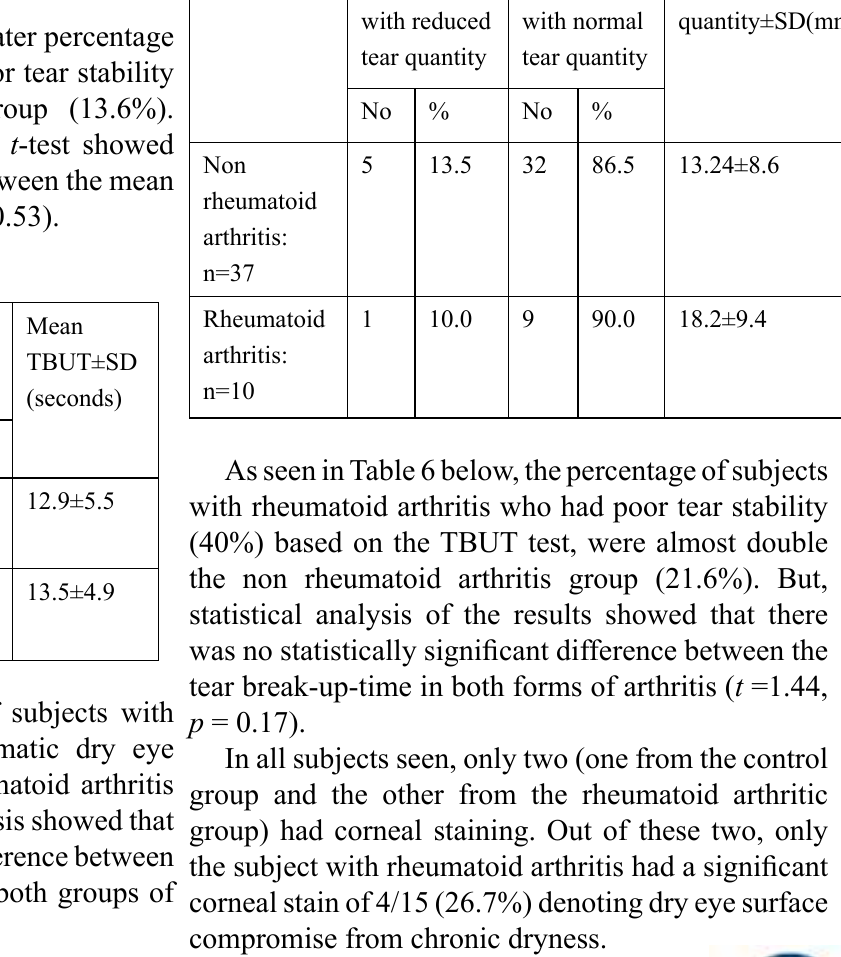
Table 5: Tear quantity in different arthritic groups Group Subjects